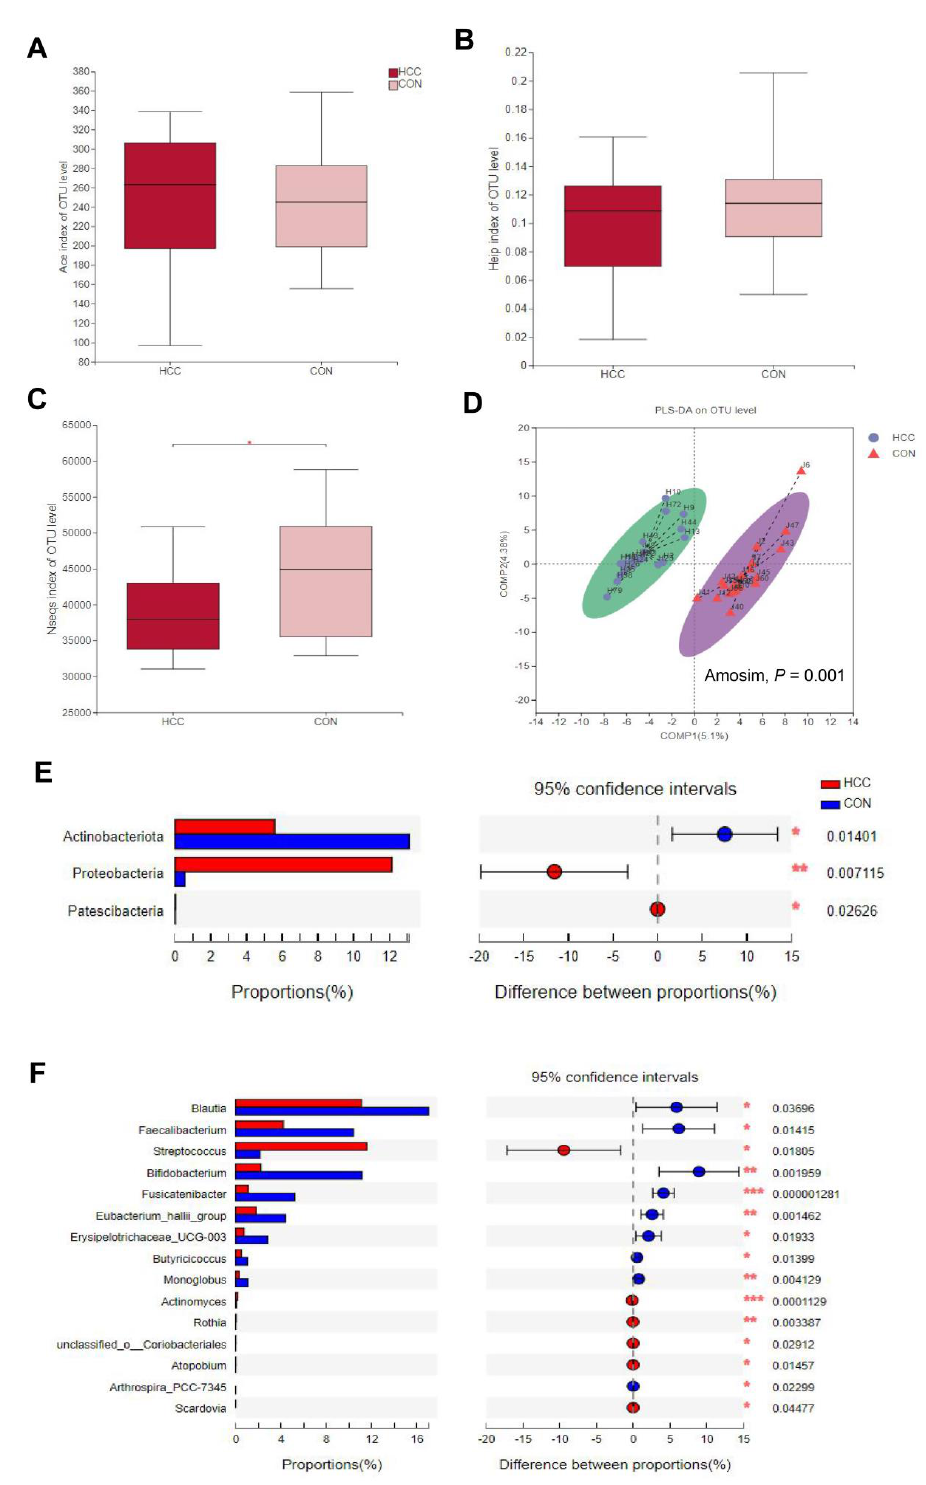
Figure 2. ( A ) Ace index, ( B ) Heip index, and ( C ) Nseqs index: differences between HCC group and CON group. ( D ) Partial least-squares discriminant analysis (PLS-DA) for OTUs between HCC group and CON group (ANOSIM, R = 0.28, p = 0.001). Wilcoxon rank-sum test. ( E , F ) Differences in gut microbiota at different levels between HCC group and CON group. ( E ) HCC group compared with CON group at phylum level. ( F ) Comparison of gut microbes at genus level between groups; * p < 0.05, ** p < 0.01, *** p < 0.001. All tested by Student’s t